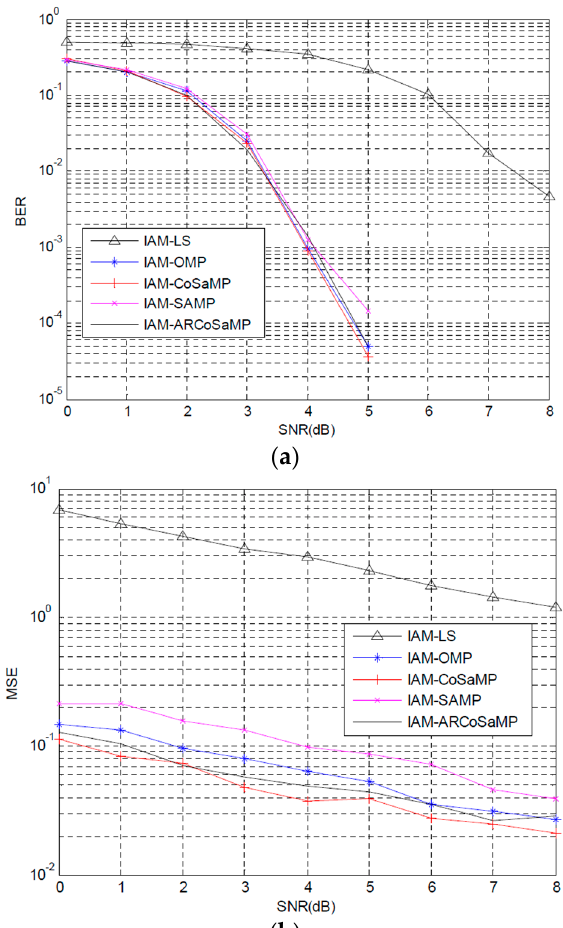
Figure 5. Bit error rate (BER) and mean square error (MSE) performance comparisons based IAM preamble structure: ( a ) BER and ( b ) MSE.